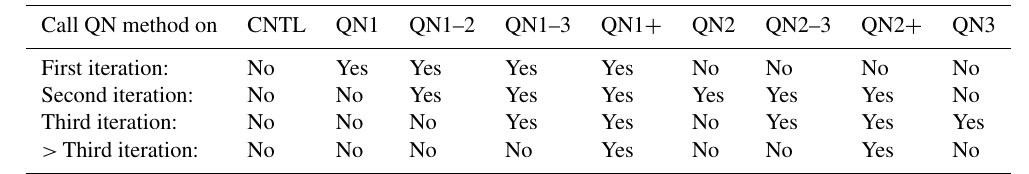
Table 3. Summary of experiments conducted using UKCA_BOX. The control (CNTL) experiment does not call the QN method. The other experiments call the QN method after one or more NR iterations.